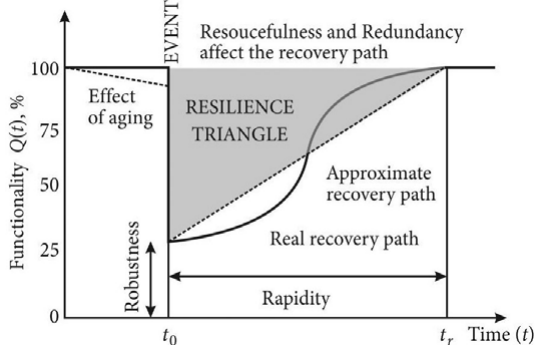
Fig. 3 . Resilience and its